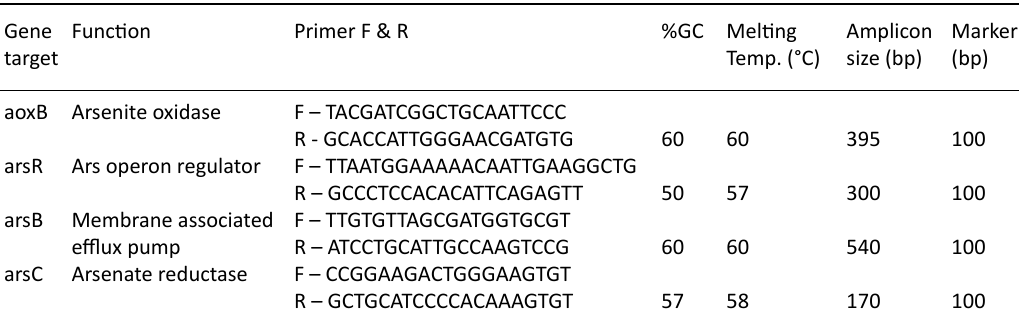
Table 5. Details of target gene, primer used and amplicon size Gene Function Primer F & R %GC Melting Amplicon Marker target Temp. (°C) size (bp) (bp) aoxB Arsenite oxidase F – TACGATCGGCTGCAATTCCC arsR Ars operon regulator arsB Membrane associated F – TTGTGTTAGCGATGGTGCGT efflux pump arsC Arsenate reductase F –